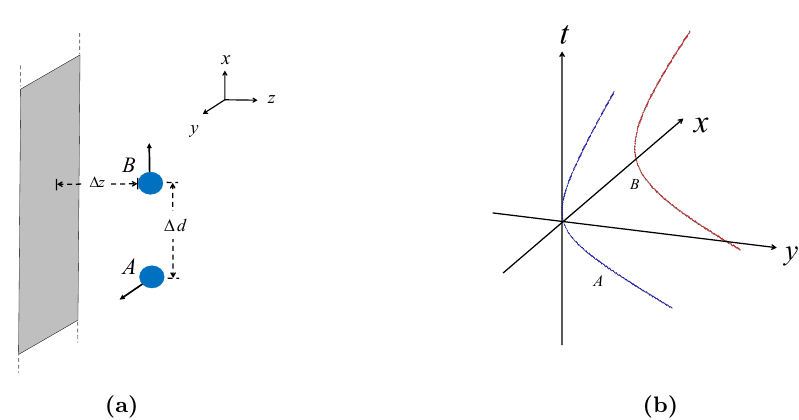
Figure 7. (a) The plot of two uniformly accelerated detectors with the acceleration in mutual perpendicular directions near the reflecting boundary, (b) the corresponding worldlines of such two detectors. Black arrows indicate the direction of